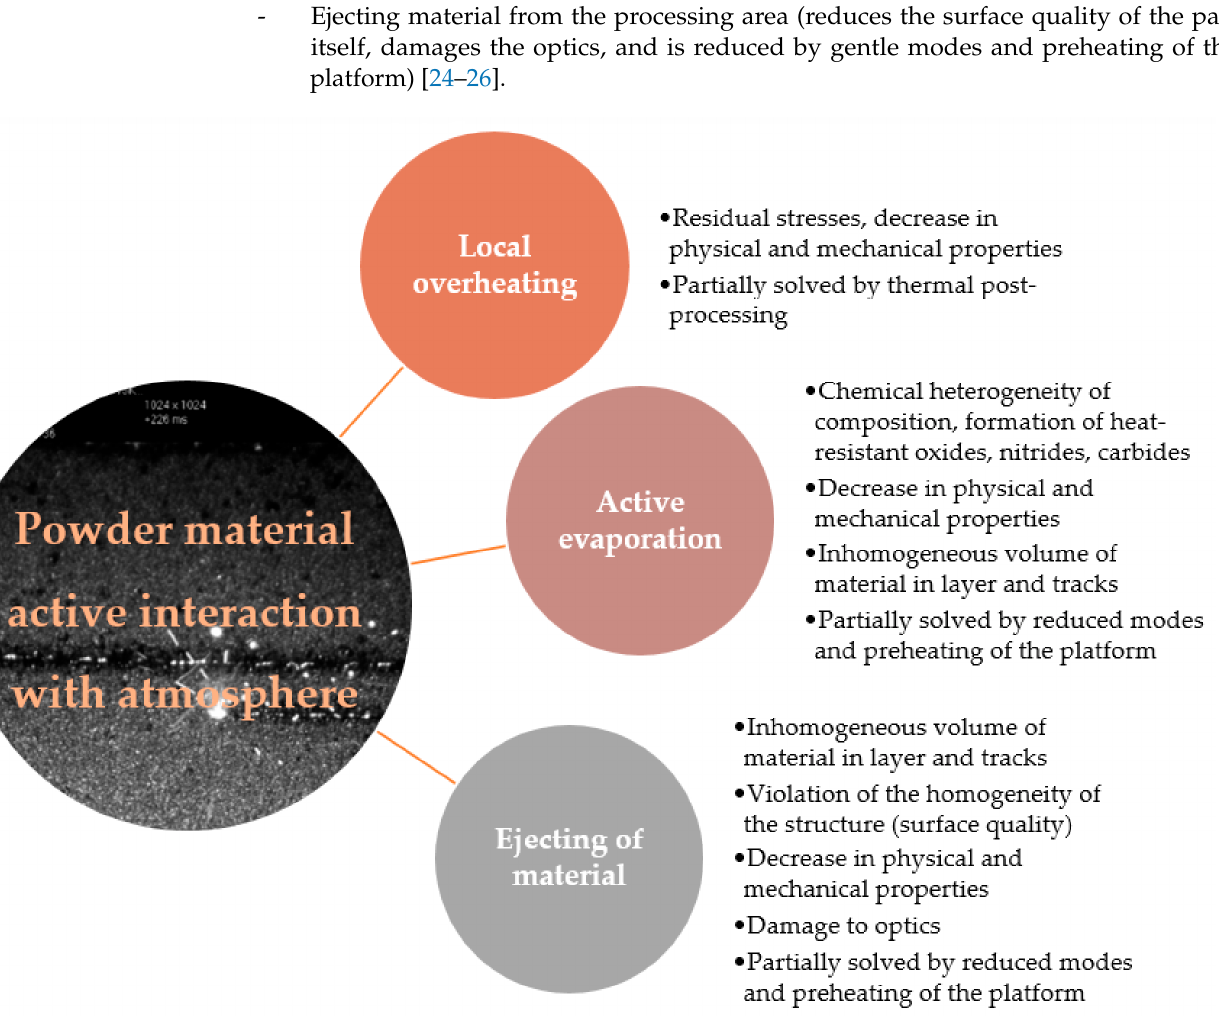
Figure 1. The main consequences of the active interaction of powder material with atmosphere and the existing ways of solving them.